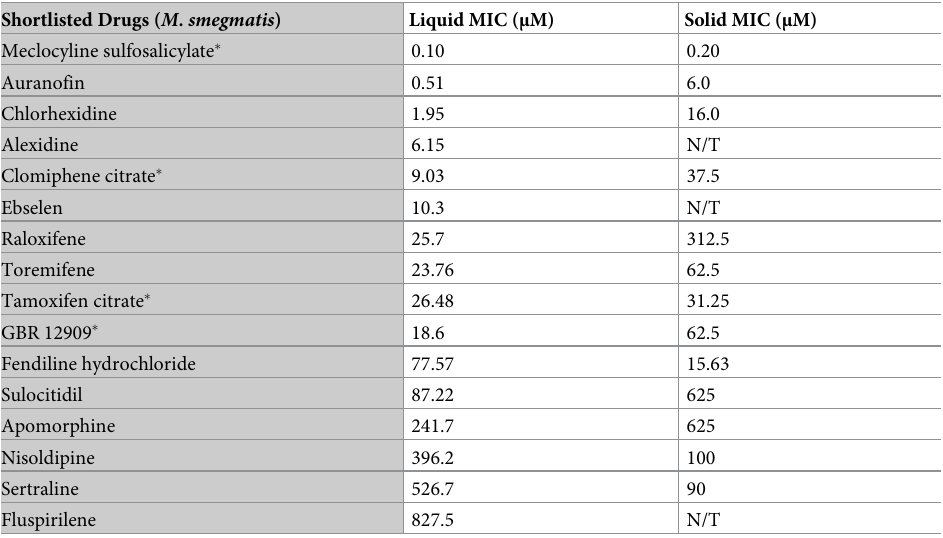
526.7 Fluspirilene 827.5 N/T MICs were determined using both liquid and solid growth mediums. (N/T)—not tested. � Selected for generation of drug resistant mutants. Experiments were carried out at least three independent times and representative data are